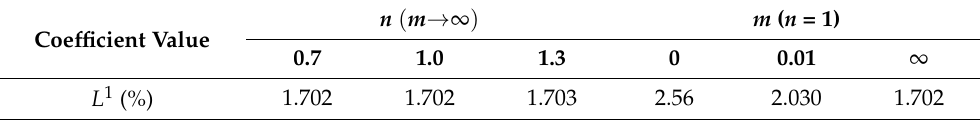
Table 1. L 1 norm of the HBP model with tuned n and m